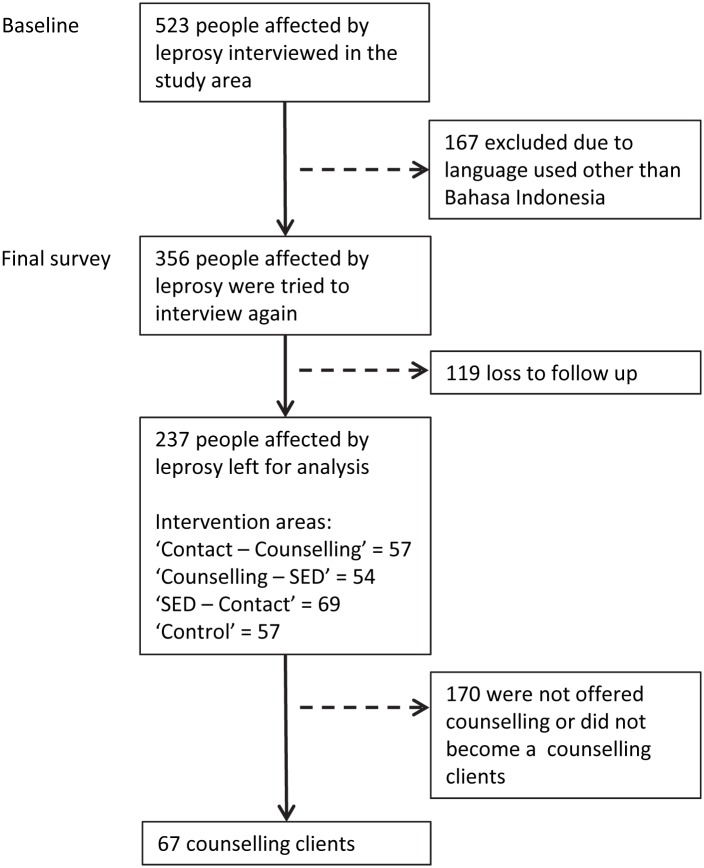
Selection procedure.